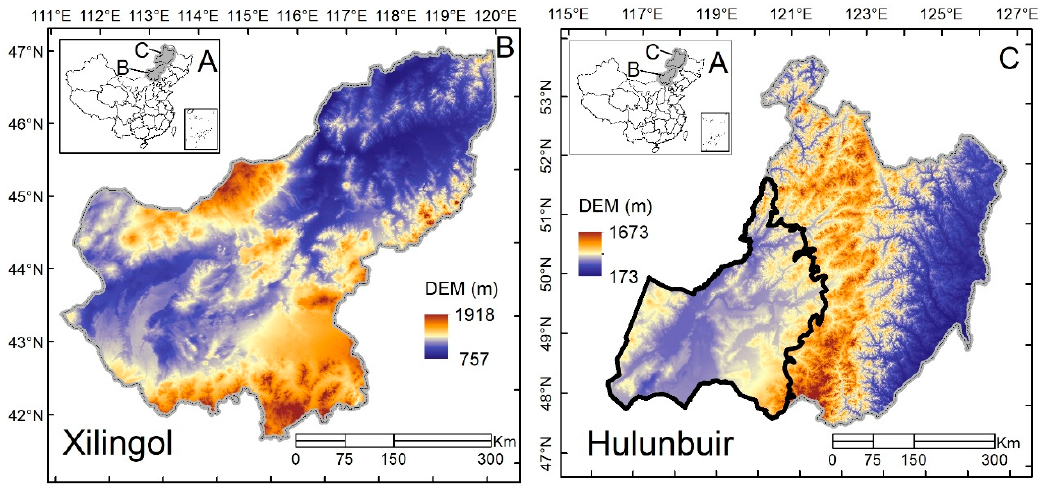
Figure 1. Elevation of the study area. The location of the study area in China is shown ( A ). The topographic elevations of Xilingol and Hulunbuir are shown ( B , C ), respectively. Grasslands are demarcated with a dark line ( C ).